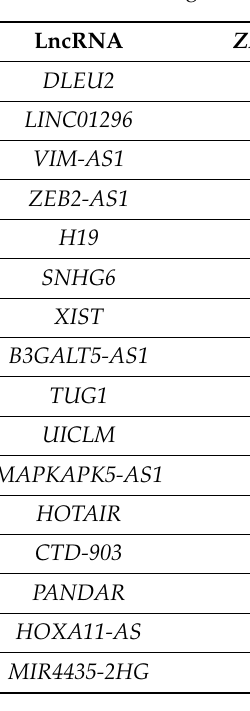
Table 2. LncRNAs regulating multiple